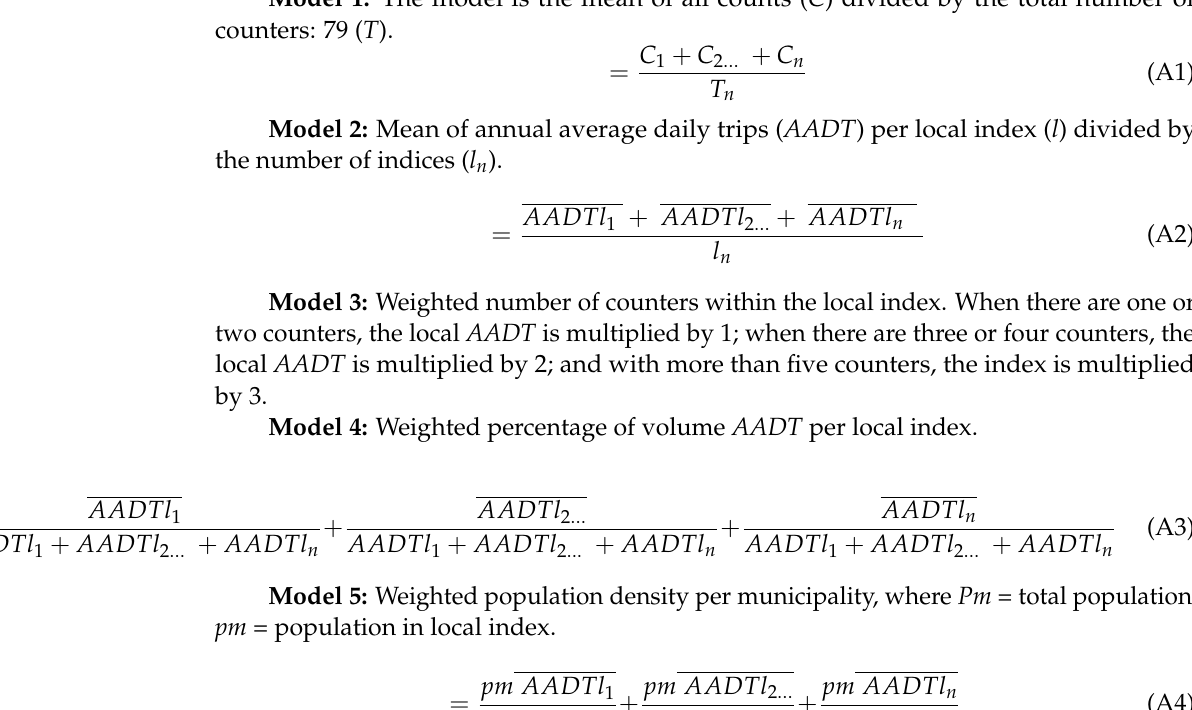
Model 6: Weighted population in 5-km grid per counter, where Pg = total population in all grids with counter, Pg = population in grid with counter, and C = counter.